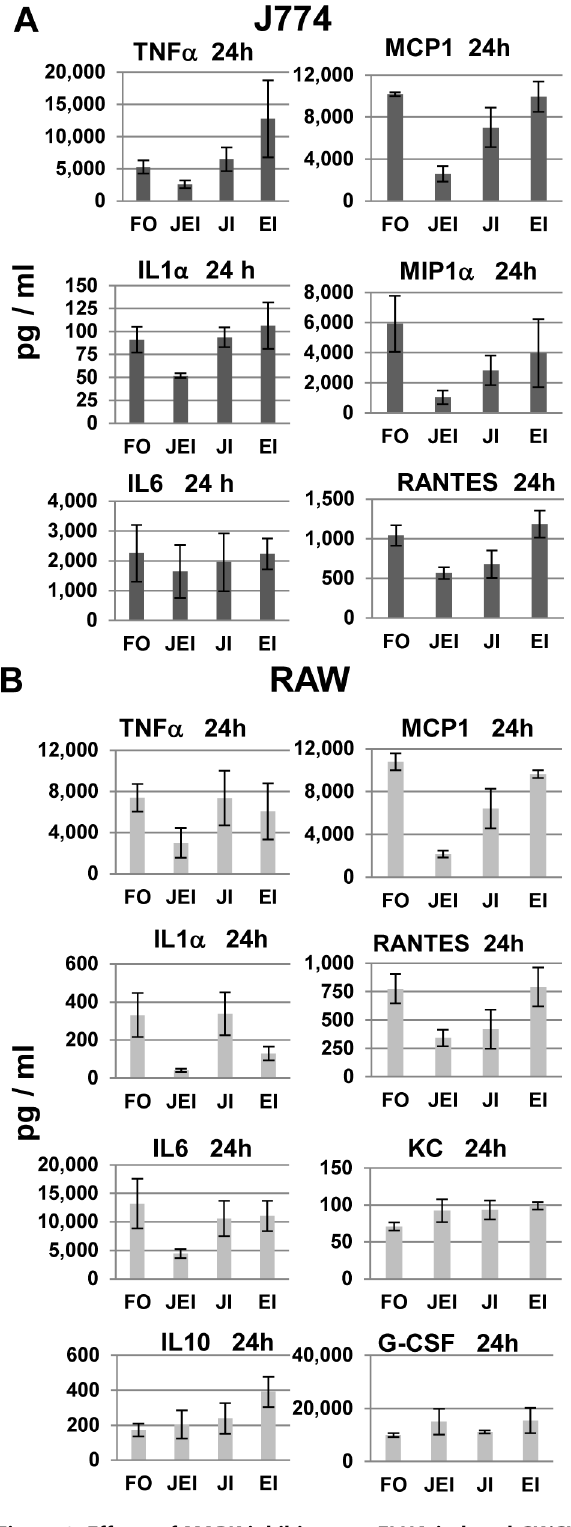
Figure 8. Effects of MAPK inhibitors on FLUA-induced CK/CHK from cell lines at 24 h. Supernatants from cells pre-treated with the indicated inhibitors as described in Methods then exposed to FLUA were collected 24 h after exposure, along with those from mock infected controls. They were assayed for selected CK/CHK by multiplexed fluid phased antibody based analysis. Cytokine concentra- tions were calculated based on known concentration standards run at